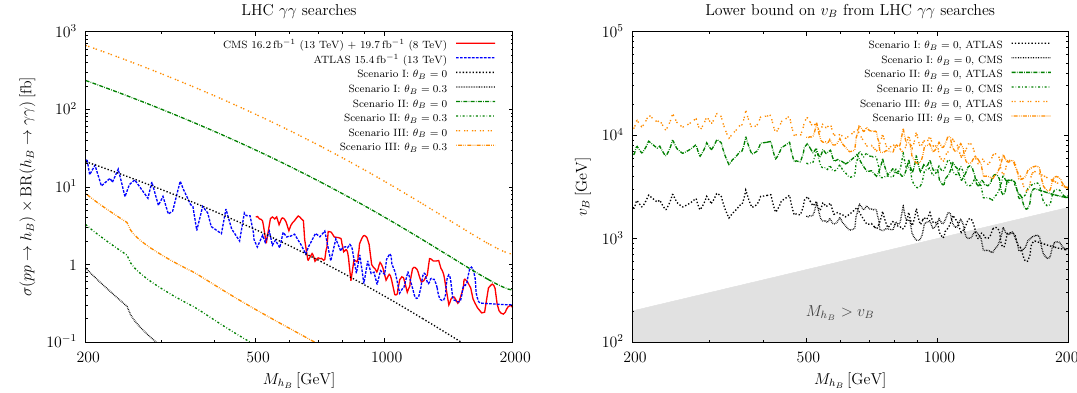
Figure 4 . Constraints from diphoton searches [26, 27]. Left panel: experimental bounds as well as cross section predictions in scenarios I, II, and III as a function of the baryonic Higgs mass. Cross sections are shown both for negligible mixing angle and for a near maximal value of (cid:18) B = 0 : 3. Right panel: experimental bounds translated into lower limits on v B as a function of M h negligible mixing. In the left panel we use v B = 2 TeV, and in both panels n f = 3 and m Q = 1 TeV.